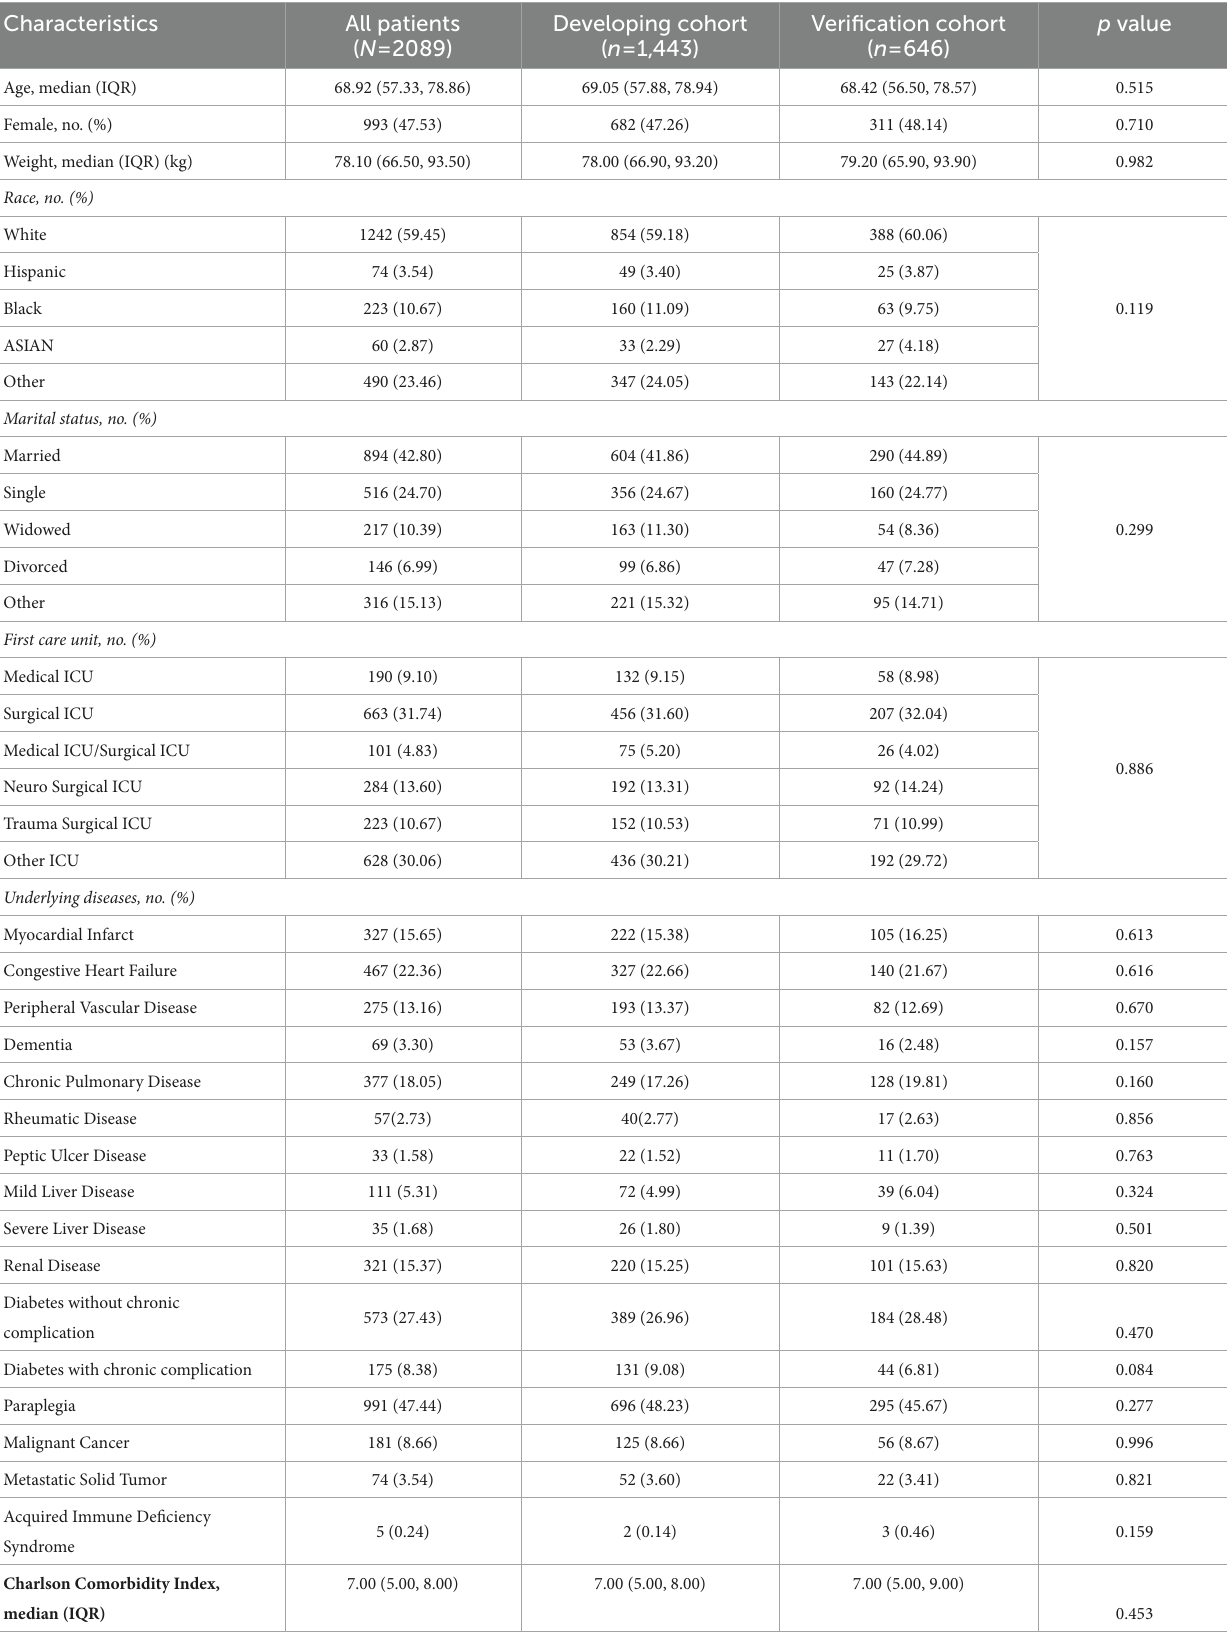
TABLE 1 Clinical characteristics of the patients with ischemic stroke.